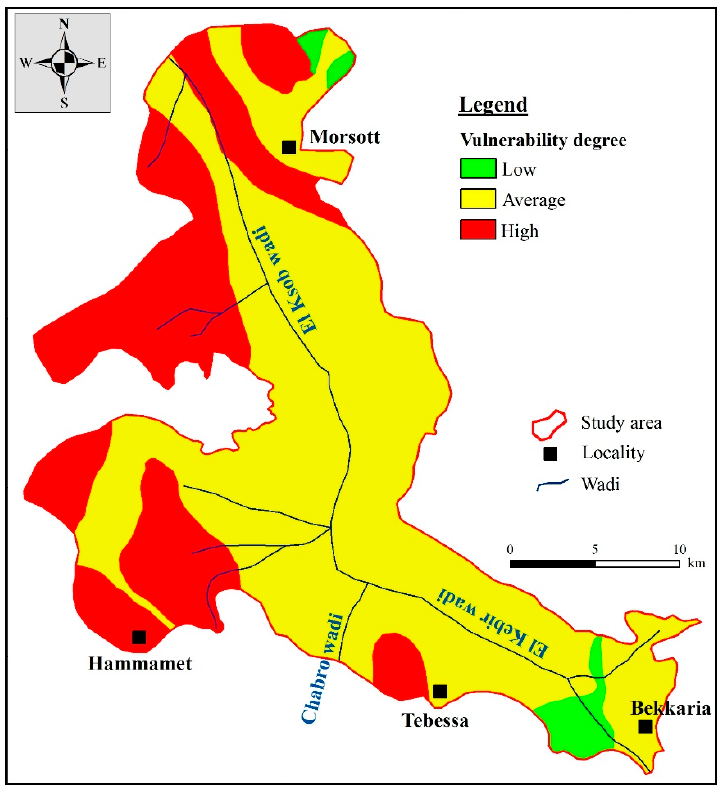
Figure 10. DRASTIC map. Three groundwater vulnerability classes were defined: (1) 52 < Vi ≤ 100: Low vulnerability (green color); (2) 101 < Vi ≤ 140: Average vulnerability (yellow color); (3) 141 < Vi ≤ 157: High vulnerability (red color).